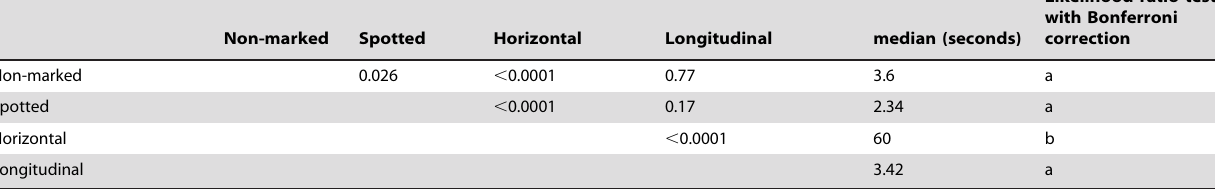
(b) Sand background